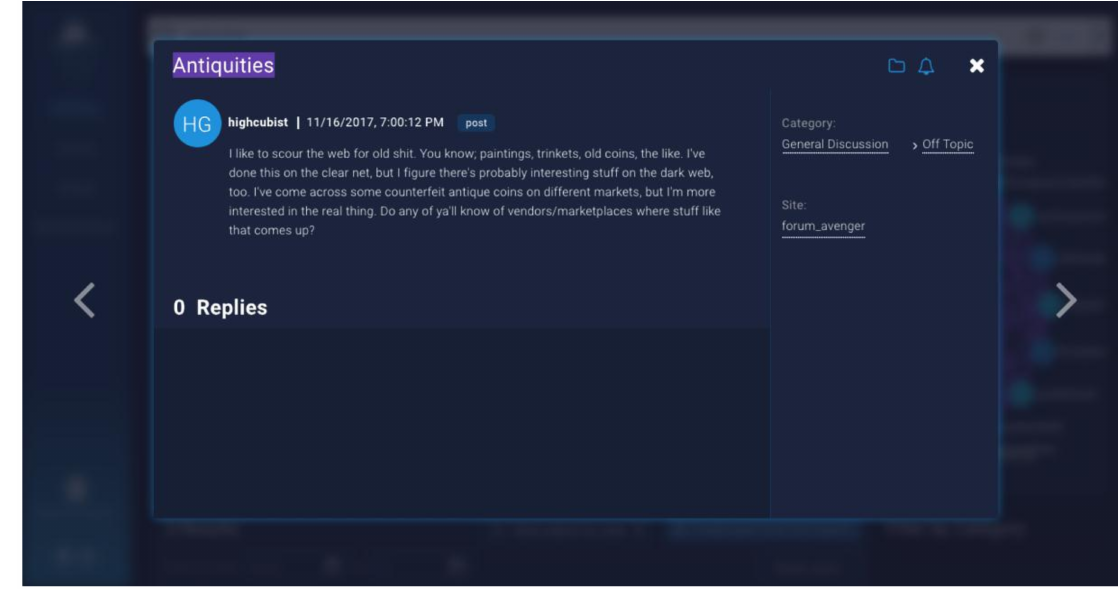
Figure 13. Screen grab of Dark Web forum user highcubist’s inquiry regarding old coins on “DNM” (i.e., Darknet Markets) accessed through the Sixgill cyber intelligence platform. (Screen grab by author